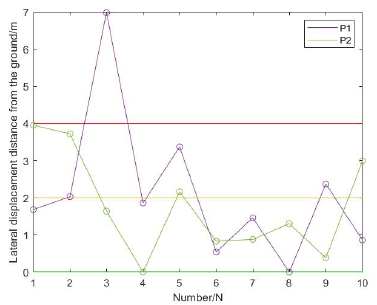
Figure 12. Lateral displacement distance from the ground.